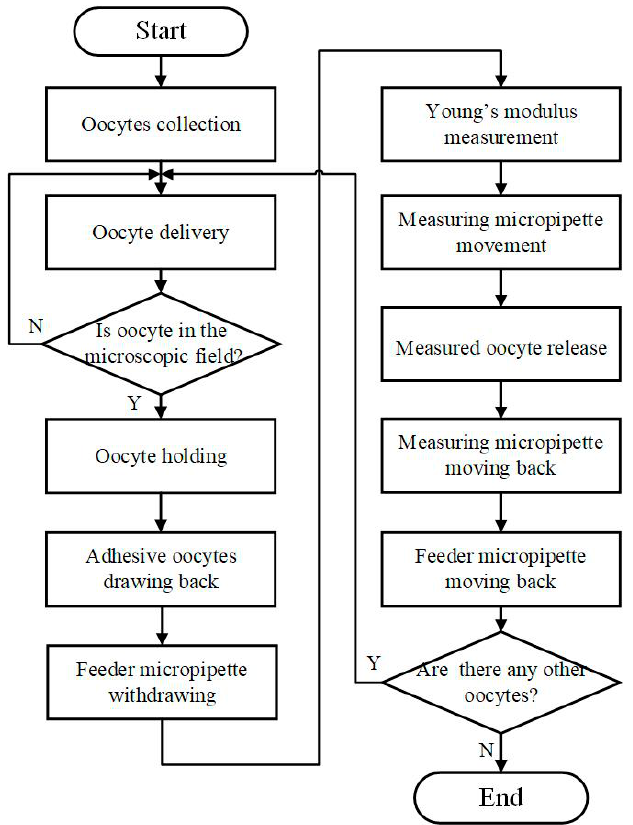
Figure 10. The operation flow of new MA process for batch cells.